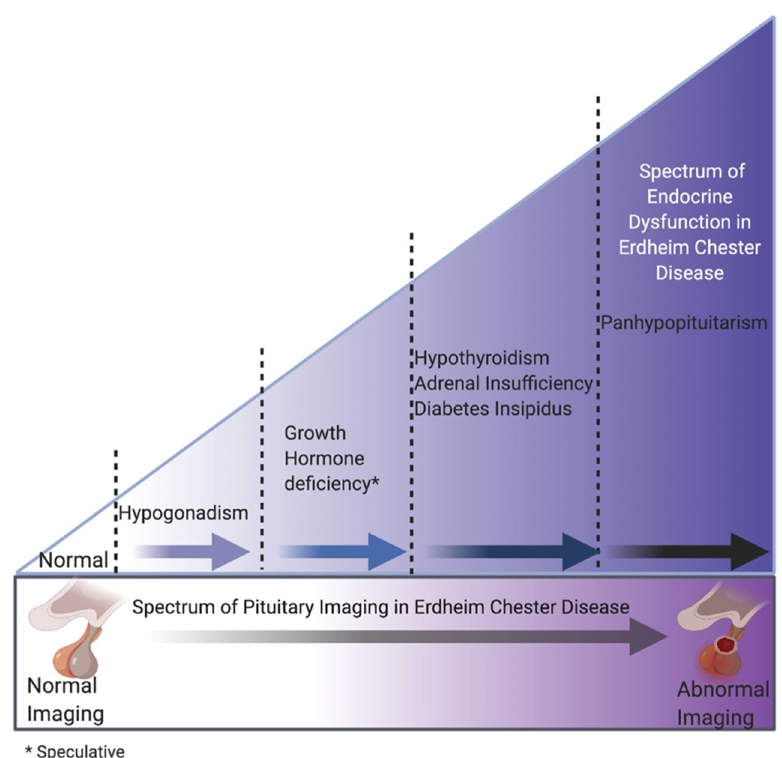
Figure 2. Proposed progression of endocrine and radiological pituitary abnormalities. Note that all hormone deficits listed are centrally occurring and hypogonadism may occur secondary to hy- perprolactinemia.